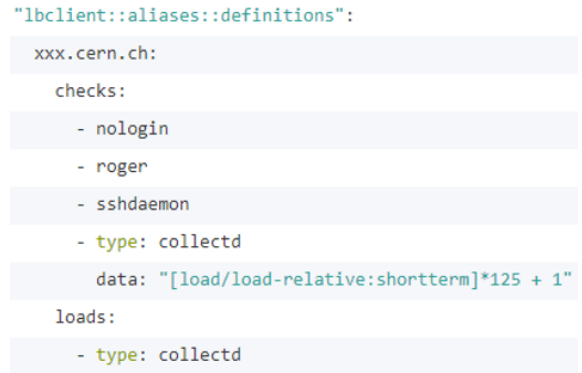
Figure 4. Puppet hiera declaration of aliases and metrics for